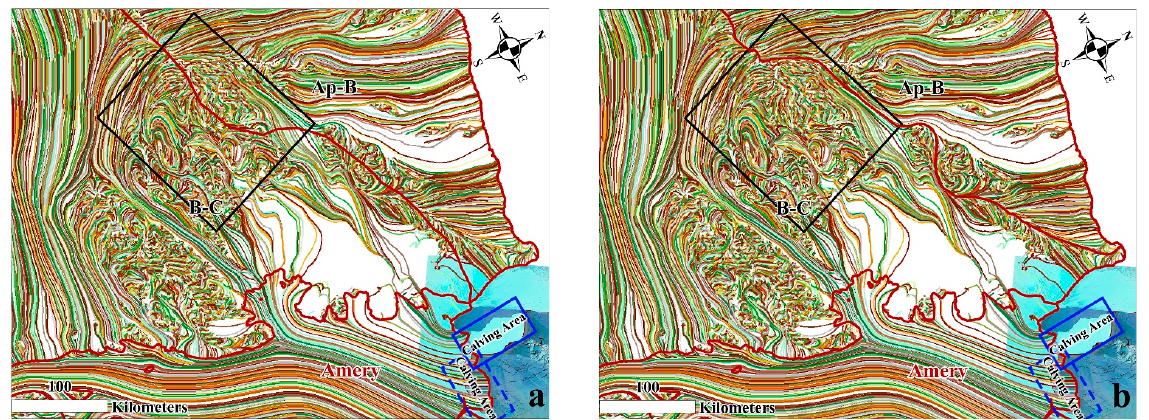
Figure 15. Amery Ice Shelf ice flow line distribution superimposed on previous and re-divided basin results. ( a ) Distribution of ice flow lines superimposed on the previous basins. ( b ) Distribution of ice flow lines superimposed on the re-divided basins.